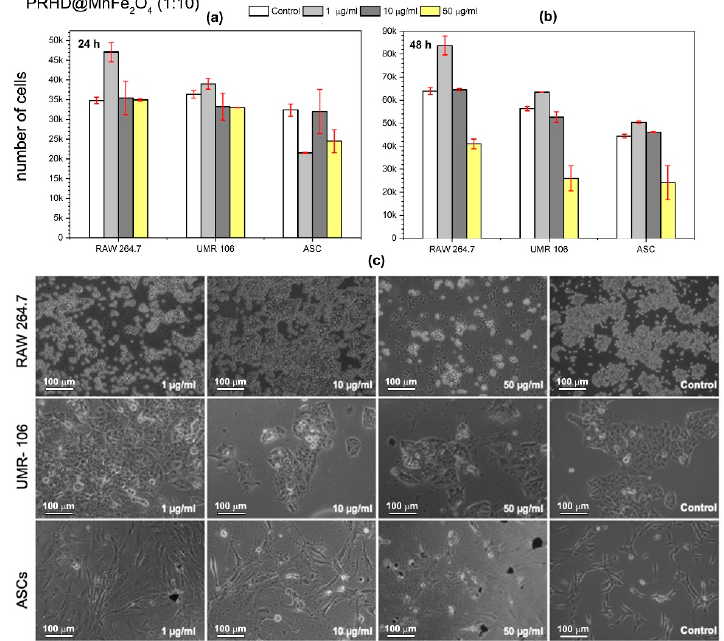
Figure 11. Effect of in vitro PPRHD@MnFe 2 O 4 (1:10) stimulation of macrophages (RAW 264.7), osteosarcoma (UMR-106), and stem (ASCs) cells proliferative activity as a function of concentration ( a ) after 24 h and ( b ) after 48 h of exposure. Panel ( c ) shows morphology changes of macrophages (RAW 264.7), osteosarcoma-derived cells (UMR-106), and stem cells (ASCs) after 48 h in vitro exposure to PRHD nanoparticles and